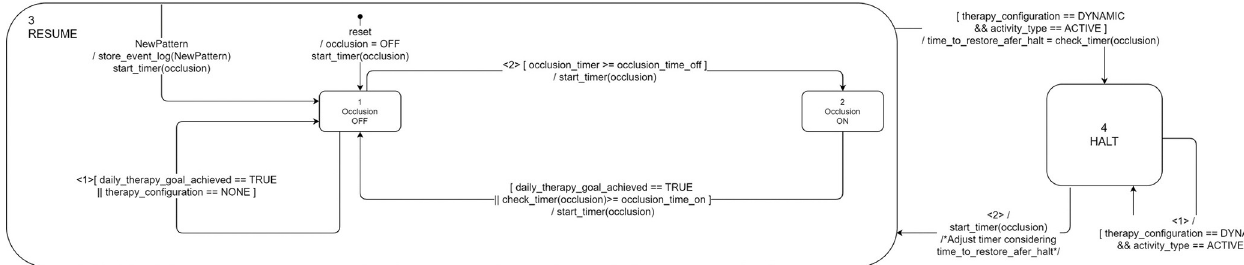
Fig 5. Occlusion finite state machine diagram.